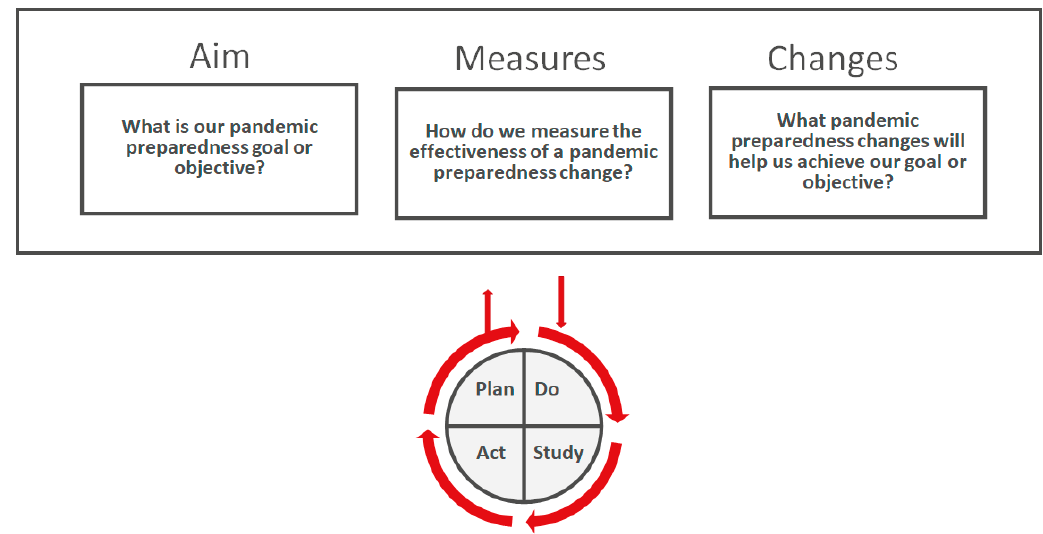
Figure 1. Four steps in a pandemic planning MFI. Pandemic planning is not a static process and required clear aims with well-designed proposed changes in practice. Effective pandemic plan- ning also requires an understanding of how to measure implemented changes. PDSA cycles allow for incremental tests of change.